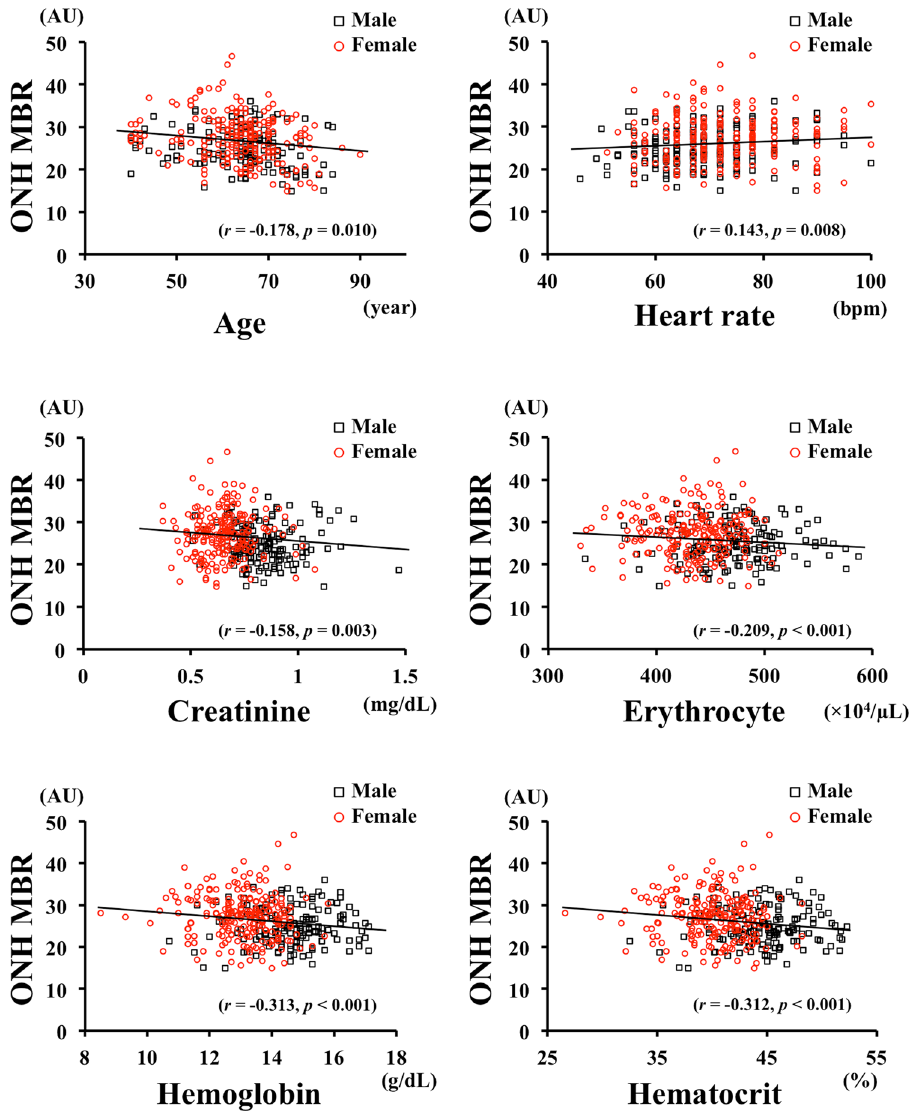
Figure 2. Correlation between the ONH-MBR and the biological characteristics of the subjects. The MBR was significantly correlated with age ( r = − 0.178, P = 0.010), heart rate ( r = 0.143, P = 0.008), serum creatinine ( r = − 0.158, P = 0.003), erythrocyte ( r = − 0.209, P < 0.001), hemoglobin ( r = − 0.313, P < 0.001), and hematocrit ( r = − 0.312, P < 0.001). Black square, males; Red circle, females.